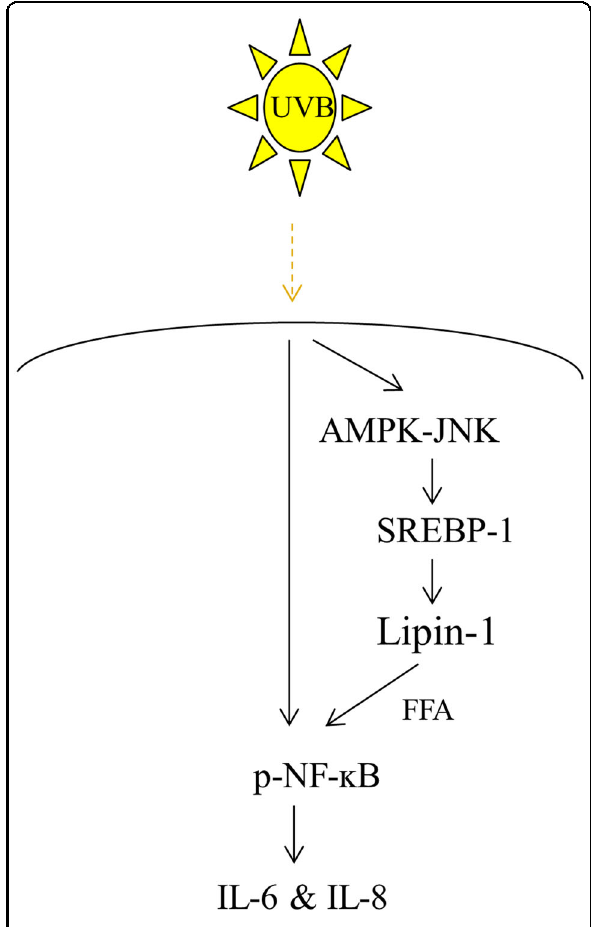
Fig. 8 Proposed mechanism of the protective action of lipin-1 inhibition against UVB-induced proin fl ammatory responses. UVB radiation inhibits lipin-1 expression in NHEKs. This inhibition is mediated by the AMPK-JNK-SREBP-1 signaling axis. Lipin-1 inhibition suppresses UVB-induced IL-6 and IL-8 production. The anti- in fl ammatory effect of lipin-1 repression may be attributed to the suppression of NF- ĸ B signaling and FFA